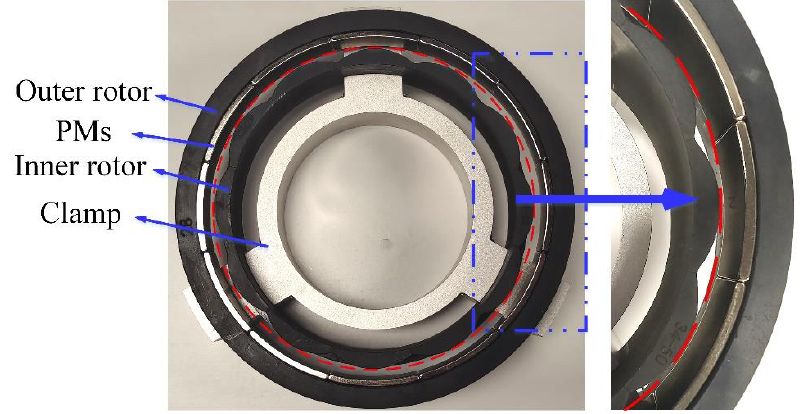
Figure 9. Prototype of inner rotor eccentricity.